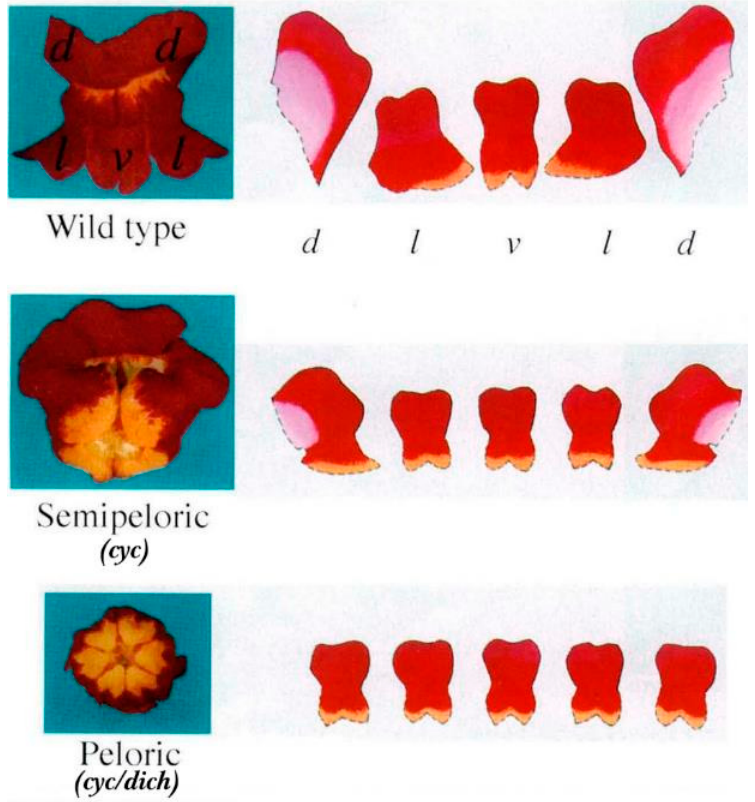
Figure 6. Flowers of wild-type and mutant snapdragon plants [1]. Photographs of the dorsal corolla lobe (d), lateral corolla lobe (l), and ventral corolla lobe (v) of the wild-type snapdragon flower are presented. The characteristics of the different corolla lobes are shown to the right of each flower. Reprinted with permission from Ref. [1]. Copyright © 2023, Nature Publishing Group.